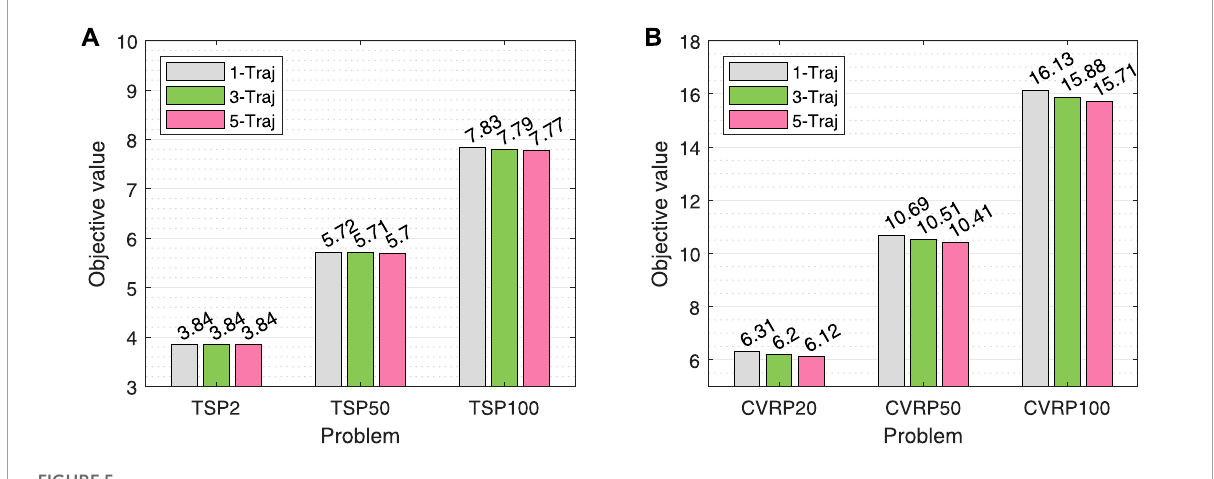
FIGURE 5 Comparison results of our proposed approach with different (1, 3, and 5) trajectories on (A) TSPs and (B) CVRPs.